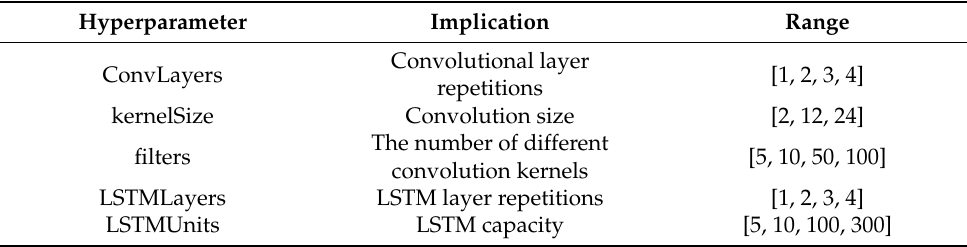
Table 3. Hyperparameter grid search for